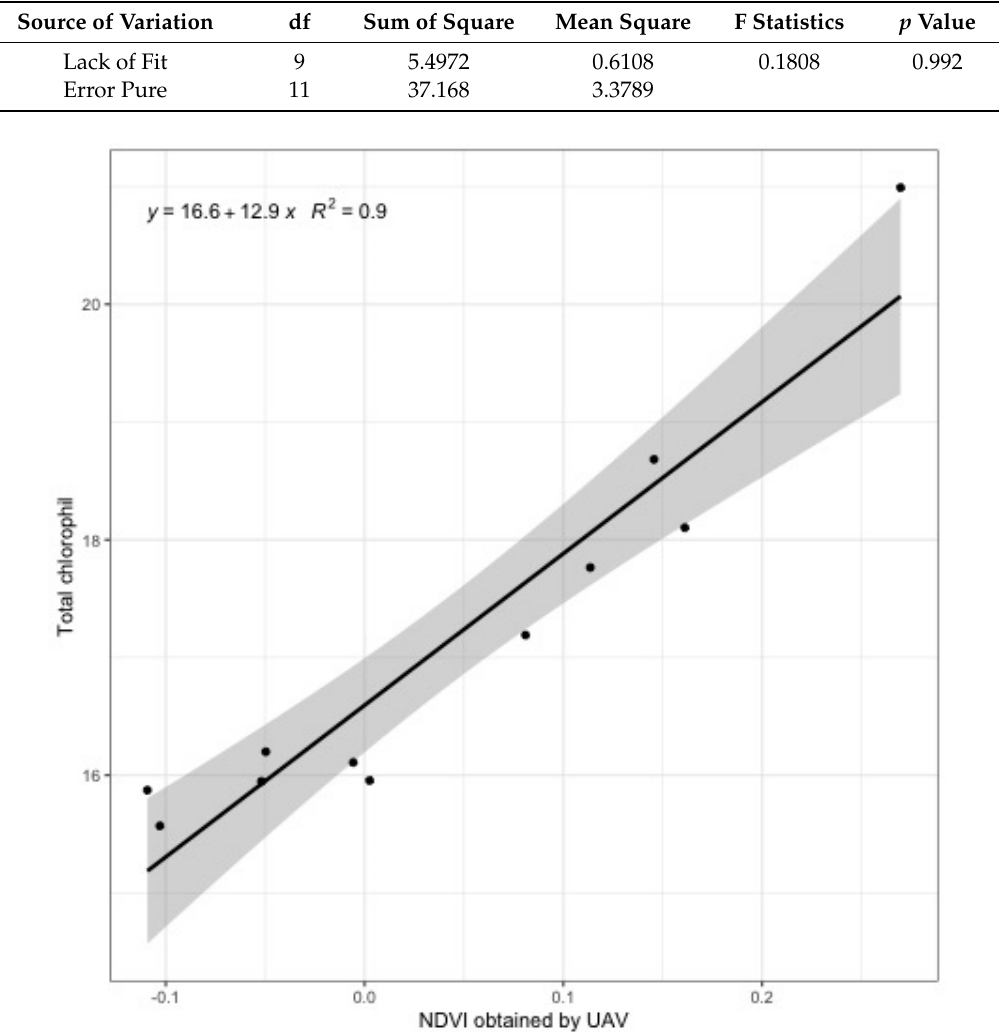
Figure 6. Simple linear regression analysis for comparison of the normalized difference vegetation index (NDVI) value determined by the unmanned aerial vehicle (UAV)-based image and ground truth chlorophyll content ( µ g · mL − 1 ) from 11 sample sites. Shadow indicates 95% confident